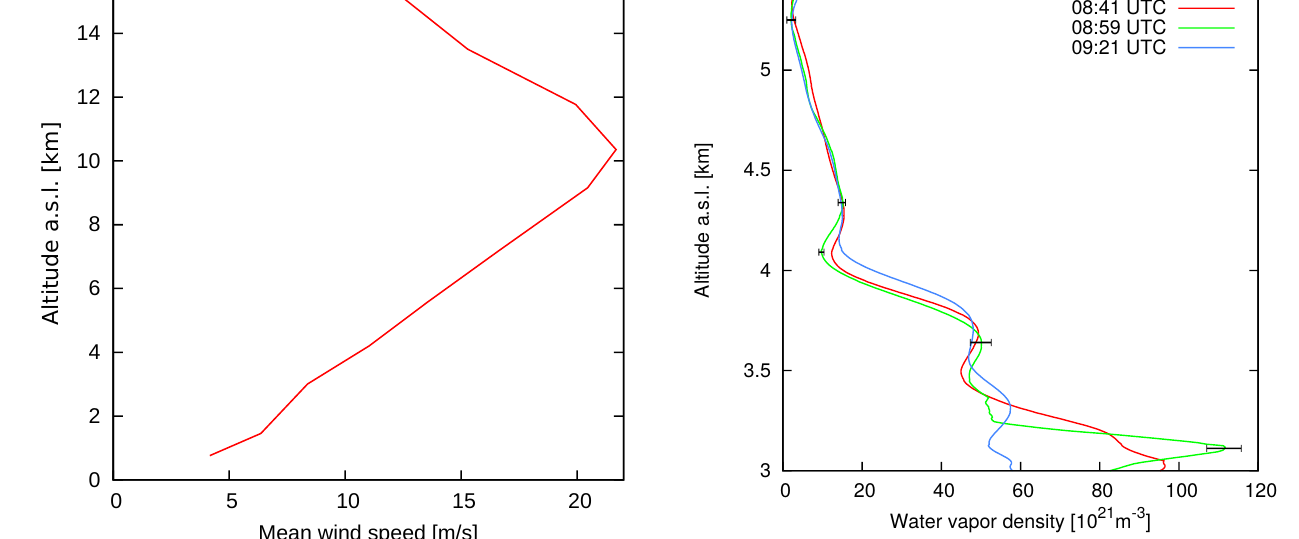
Figure 7. Mean wind speed above the Zugspitze as a function of al- titude (data from the National Center for Environmental Prediction, NCEP). Under the jet stream regime, the wind velocity at 10km can occasionally exceed 100ms − 1 .